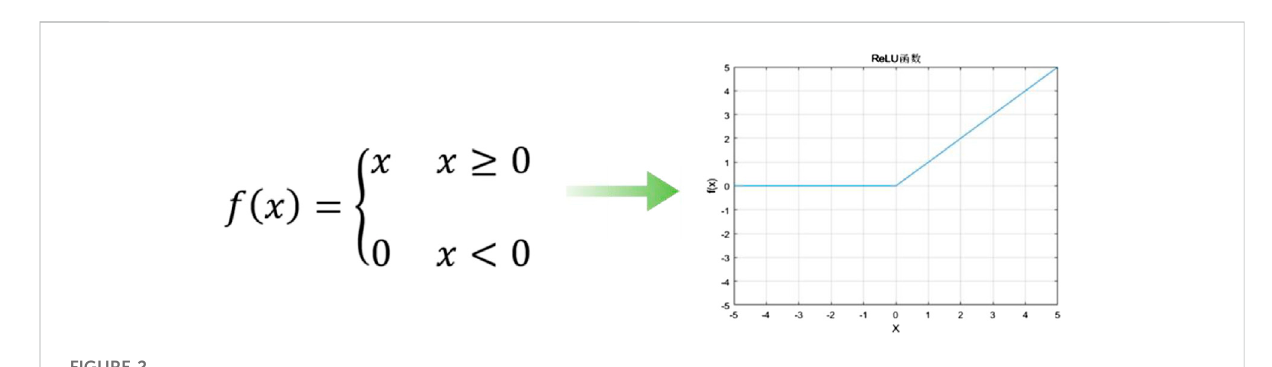
FIGURE 2 ReLU function and function